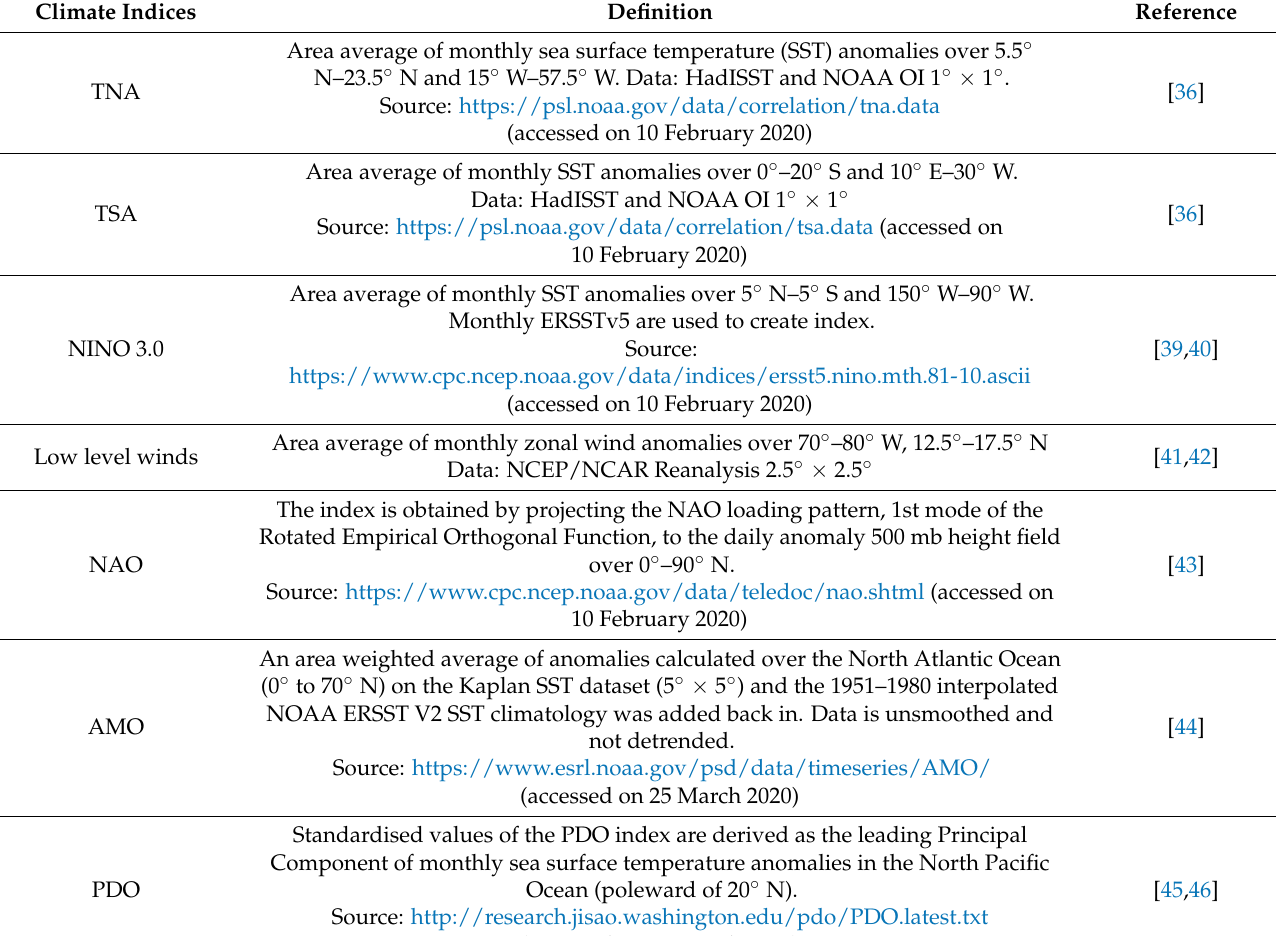
Table 3. Some climate indices used in correlation analyses. Anomalies are calculated relative to 2001–2019. Climate Indices Definition